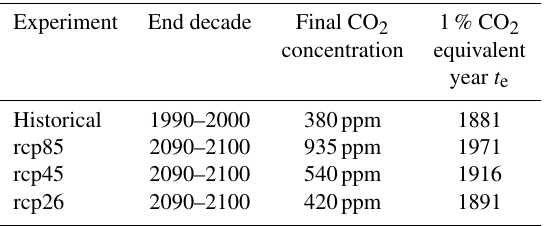
Table 1. CO 2 concentration at the end of each experiment, taken from the IPCC’s 5th Assessment Report (Table AII.4.1 on p. 1422, Stocker, 2014) and rounded. End decade denotes the last decade that is completely contained in an experiment. The 1% CO 2 equivalent year corresponds to the year in which the same CO 2 is achieved following a 1% per year growth trajectory that starts in